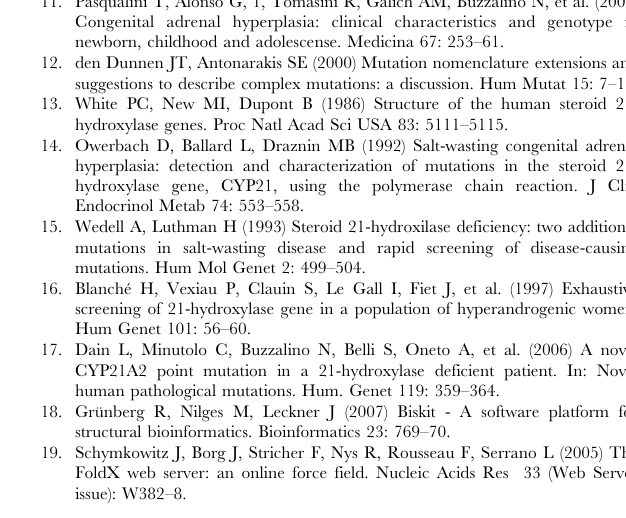
Figure S1 Correlation between experimental activities and predicted stabilities . Forty mutants in Human P450CYP21A2 protein with published in vitro functional studies